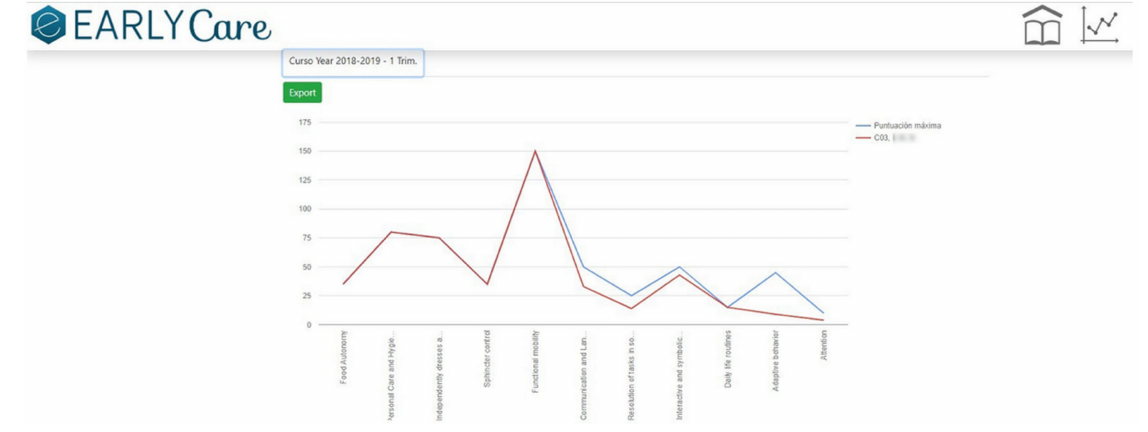
Figure 2. A patient’s functional ability development profile.